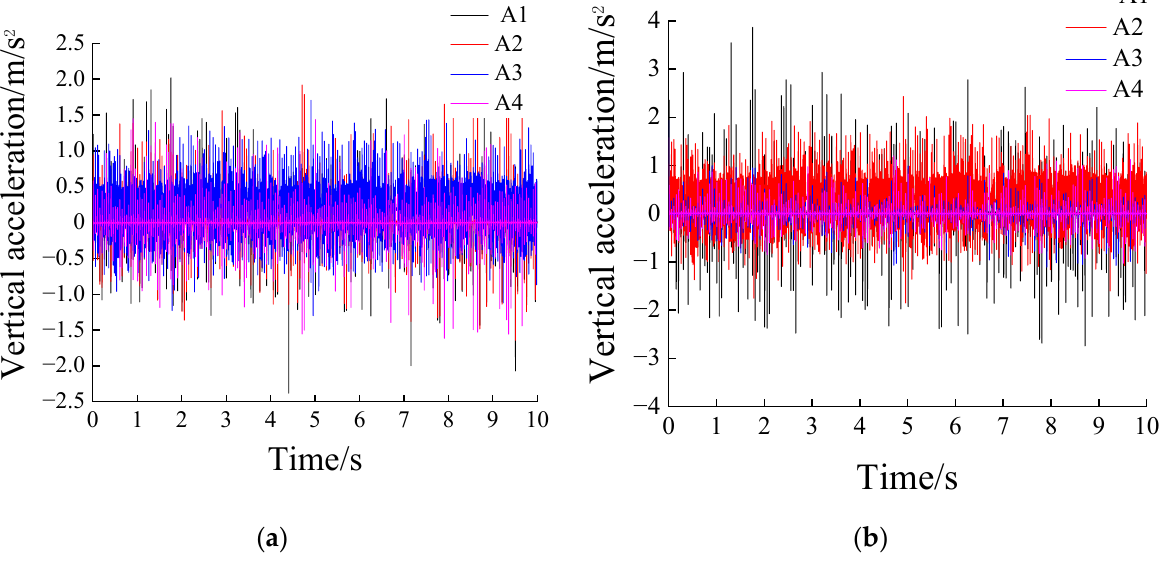
Figure 14. Acceleration time course curve of the tunnel axial measuring points: ( a ) no base void; ( b ) with base void.